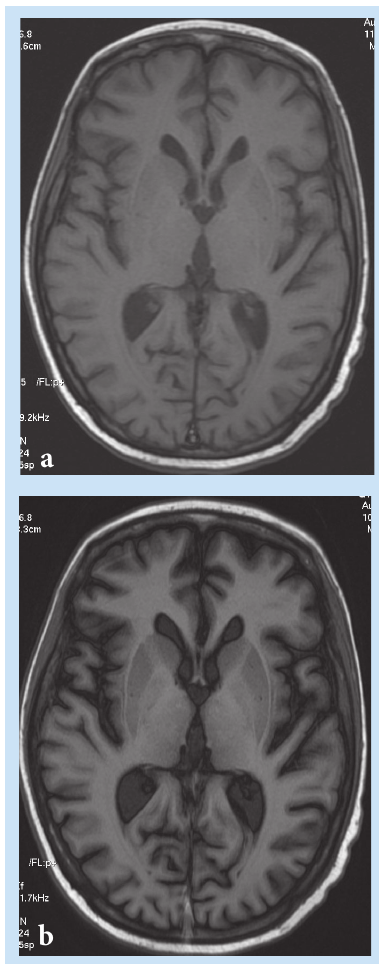
Figs 3 a and b: T1 and T1 FLAIR images of the basal